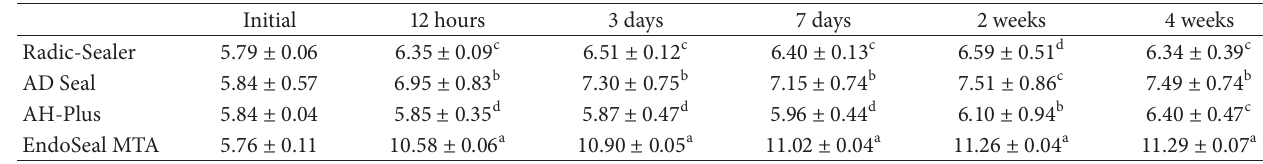
Table 6: pH change of set samples during 4 weeks.